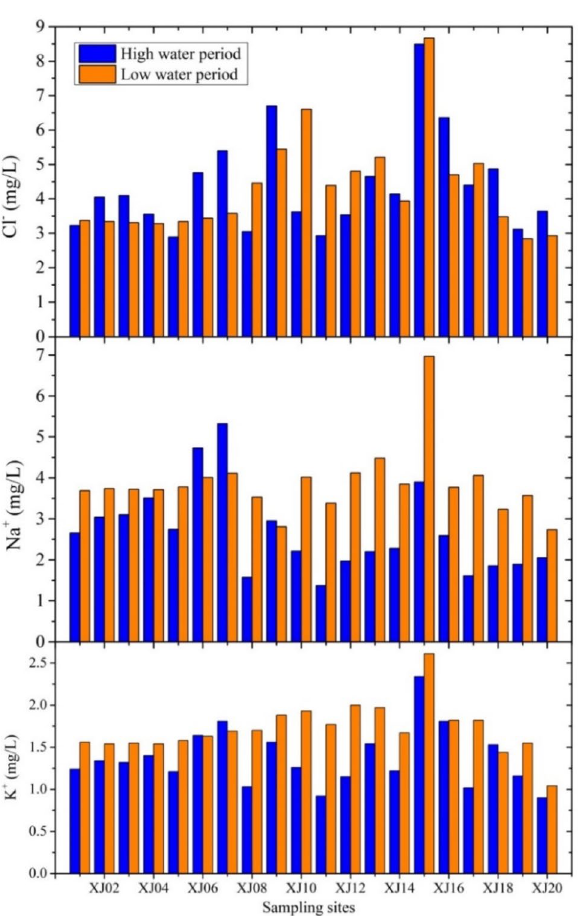
Figure 6. Variations in the K + , Na + , and Cl − concentrations of the Xijiang River during the high (in blue) and low (in red) water